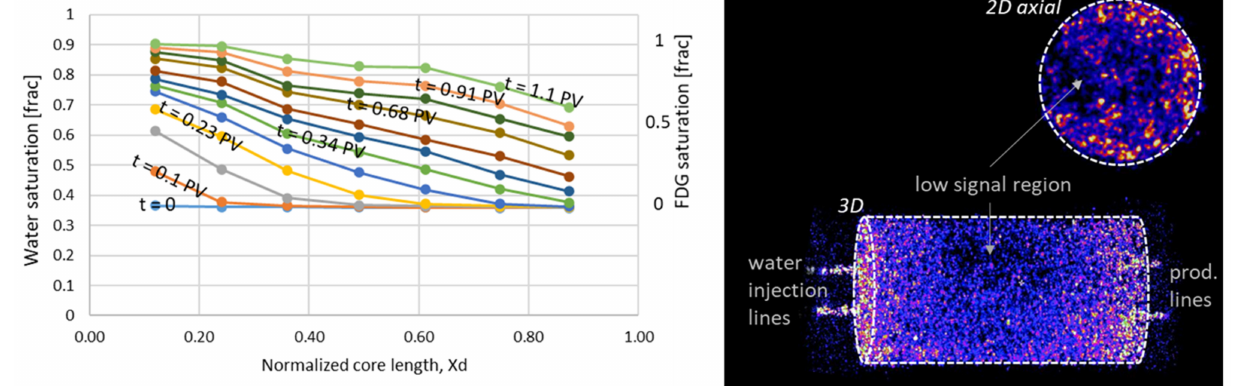
Figure 11. ( Left ) 1D saturation profiles for core LS27 during the first waterflood, showing a less than ideal displacement. Oil recovery was efficient until water breakthrough (t = 0.39 PV), and continued to increase until 1.1 PV of water was injected. No change in saturation was observed between t = 1.1–2 PV injected. ( Right ) A 3D rendering of the flooded core at static, no-flow conditions show a low-signal region in the core middle, which was not efficiently flooded by